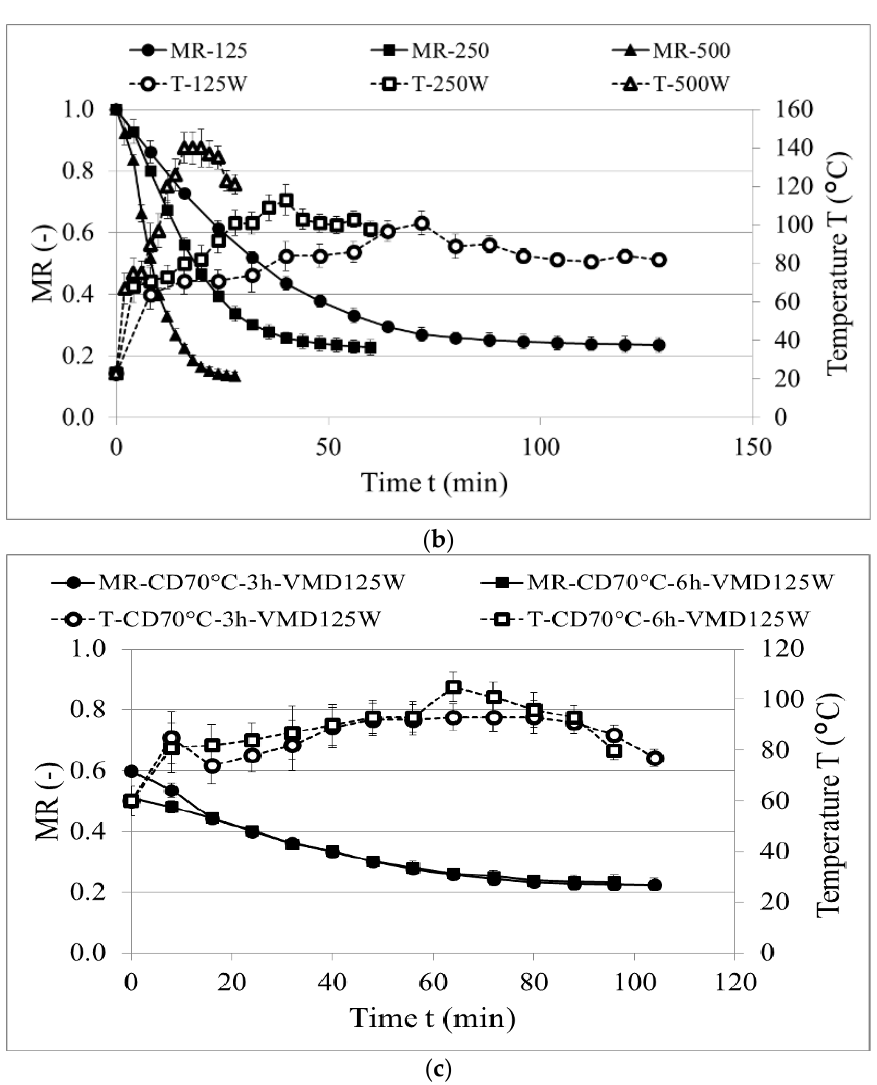
Figure 2. Drying kinetics of black garlic dried using convective pre-drying and vacuum finishing drying ( a ), vacuum-microwave drying ( b ), and combined convective pre-drying followed by vacuum-microwave finishing drying ( c ).